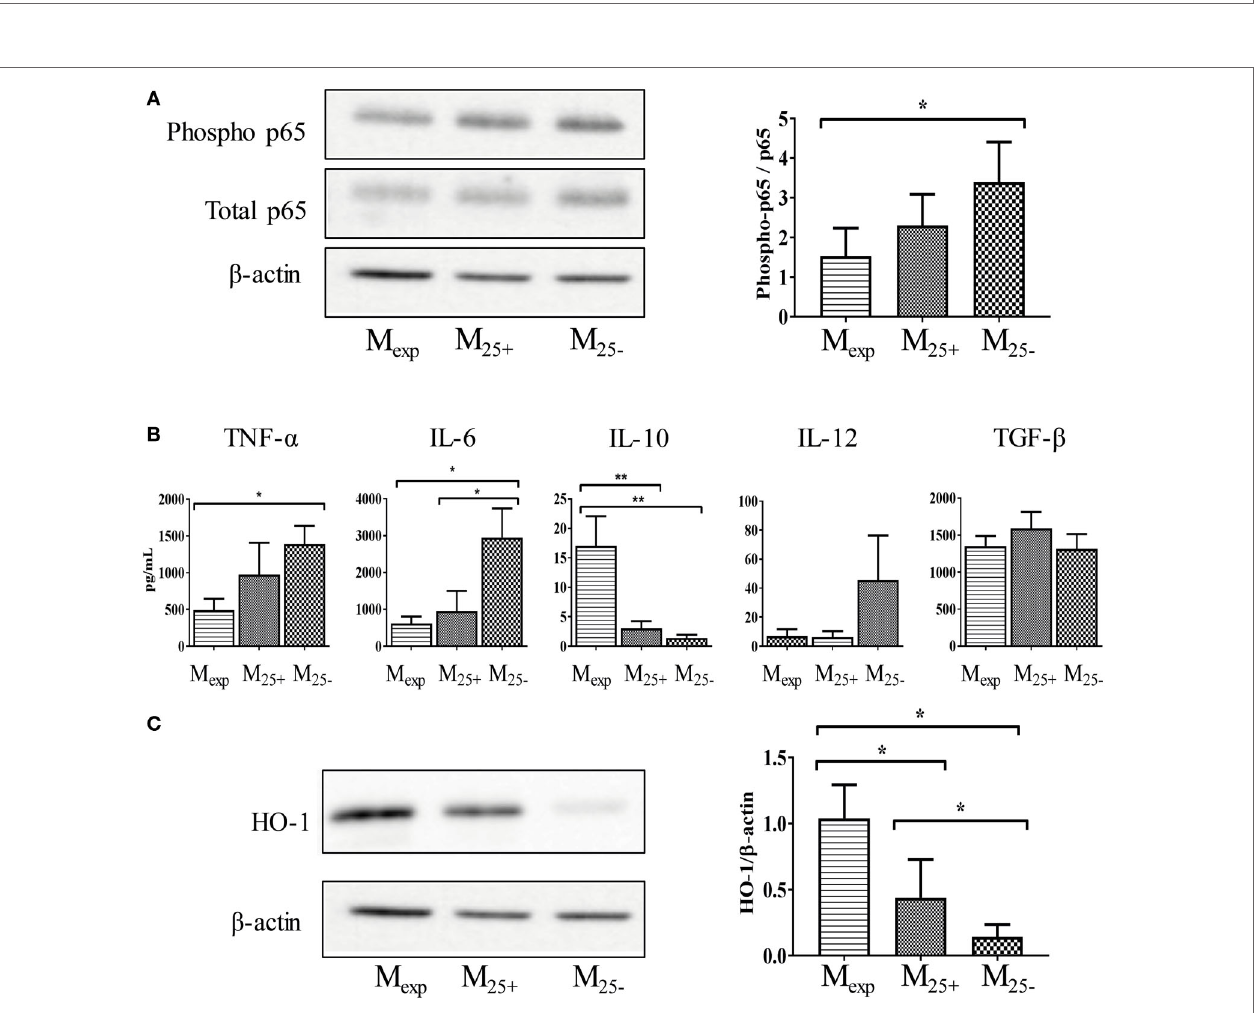
FigUre 4 | M exp showed a reduced activation status compared with M 25 + and M 25 − . (a) Representative WB showing the expression of phosphorylated and total p65 and β -actin in M exp , M 25 + , and M 25 − (left panels); cumulative data of four independent experiments showing the ratio between phosphorylated and total p65 (right panel) in M exp , M 25 + , and M 25 − cells. (B) Cytokine production of sorted M exp , M 25 + , and M 25 − after LPS stimulation (50 ng/mL) for 24 h. (c) Representative WB showing the expression of β -actin and heme oxygenase-1 (HO-1) in M exp , M 25 + , and M 25 − (left panels); cumulative data of four independent experiments showing the ratio between HO-1 and β -actin (right panel) in M exp , M 25 + , and M 25 − cells. In all the experiments, data, presented as mean ± SEM, were analyzed using one-way ANOVA followed by Tukey with * p < 0.05, ** p < 0.01. Full length-blots are presented in Figure S4 in Supplementary Material. The same representative β -actin blot is shown in panels (a,c) .